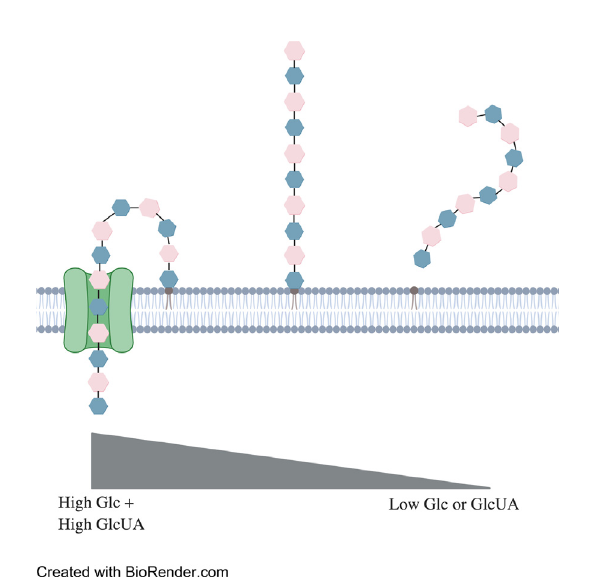
FIGURE 3 | Representation of synthase-mediated CPS production. Synthesis begins when a glucose monosaccharide is transferred to an integral phosphatidylglycerol. Addition of a glucuronic acid is catalyzed by the synthase. This method repeats until concentrations of either sugar runs too low for synthesis to continue. The phosphatidylglycerol then dissociates from the synthase and disperses within the external cell